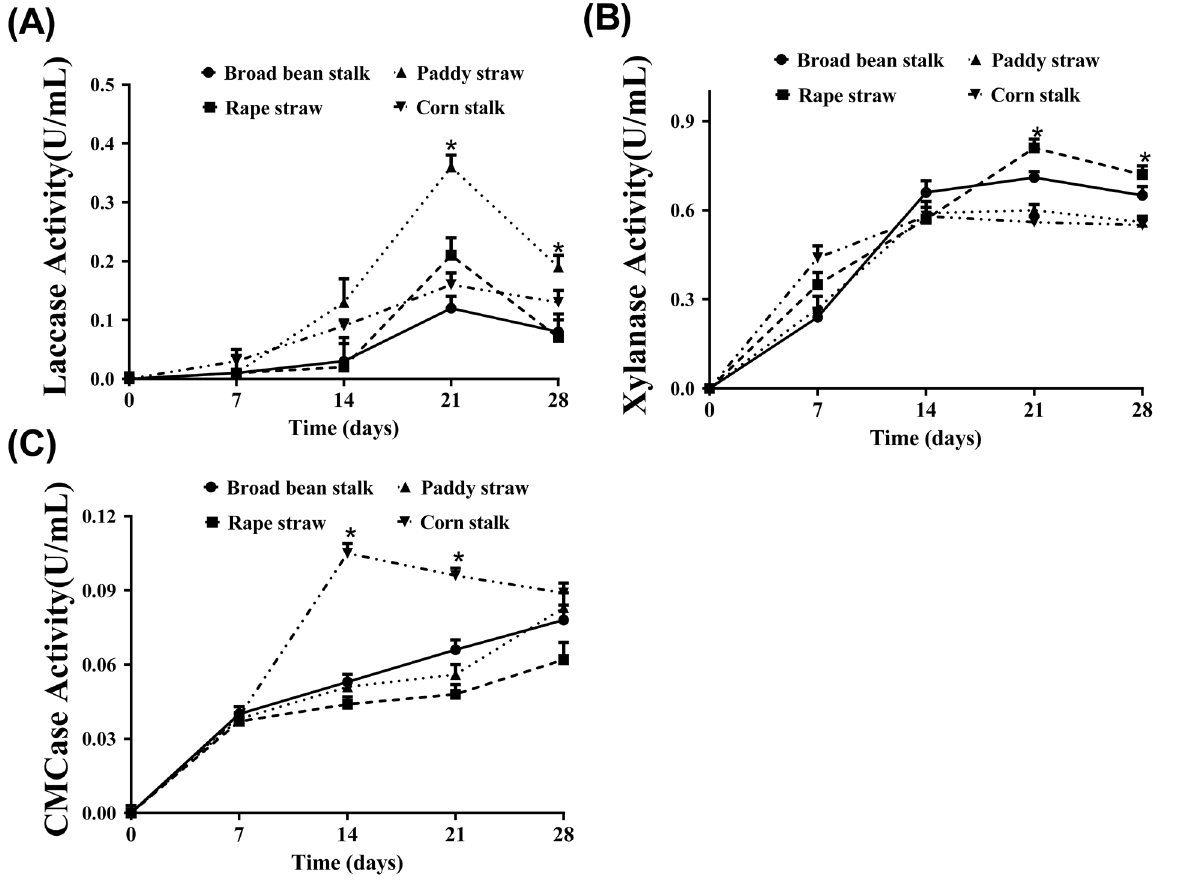
Figure 1. Crucial degrading enzymes activities of Pleurotus ostreatus cultured with Broad bean stalk ( ● and ▬ ), Paddy straw ( ▲ and ∙∙∙), Rape straw ( ■ and ---), and Corn straw ( ▼ and − ⸱⸱ −) at 0, 7, 14, 21, and 28 day of co-culturing time. (A) Enzyme activity of laccase of Pleurotus ostreatus; (B) Enzyme activity of Xylanase of Pleurotus ostreatus; (C) Enzyme activity of carboxymethylcellulase of Pleurotus ostreatus. The symbolic of * indicates significant different